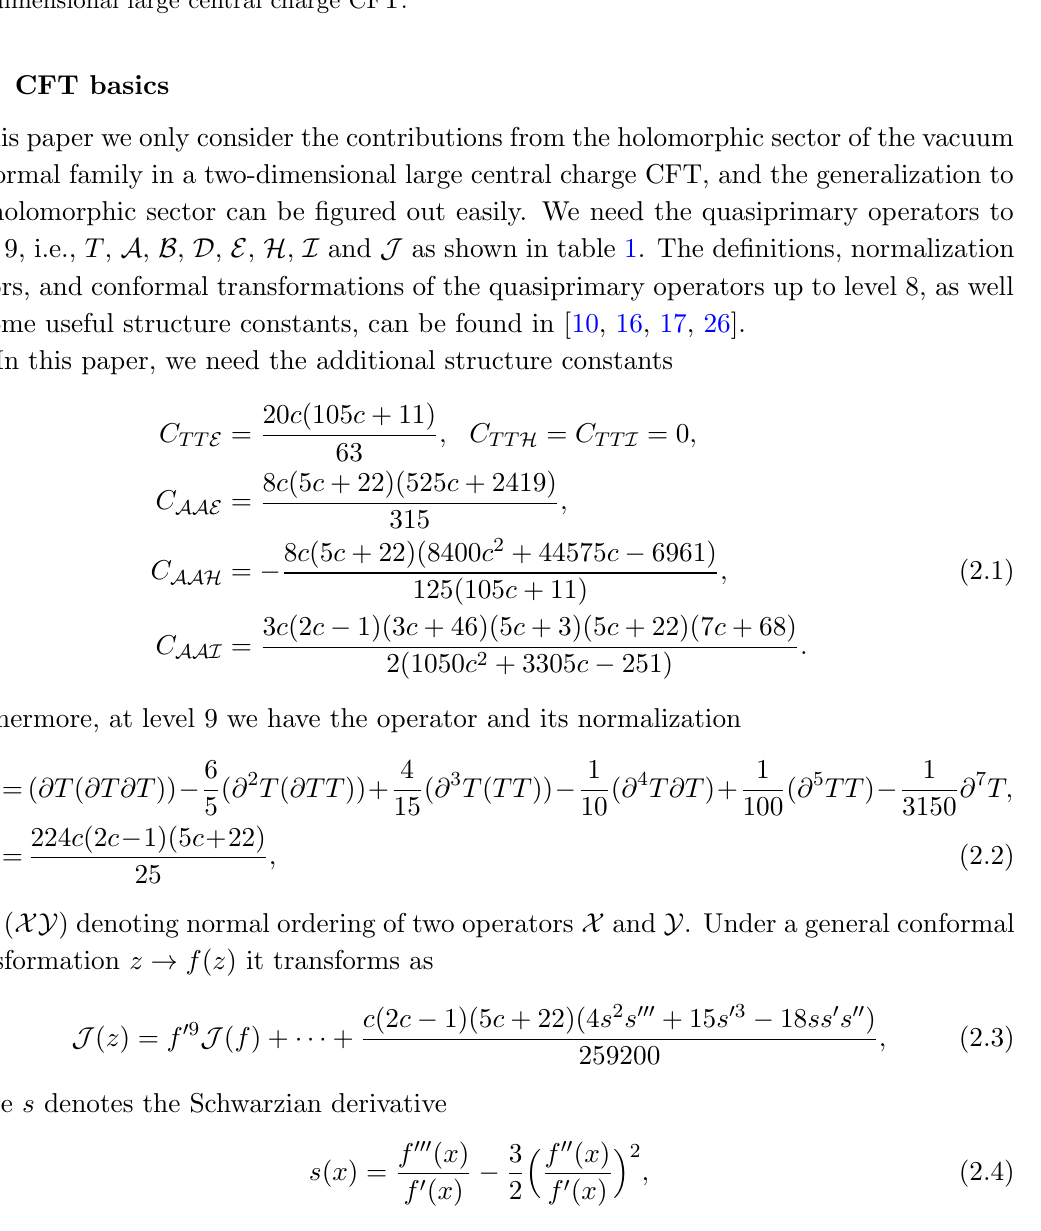
Table 1. The holomorphic quasiprimary operators to level 9 in vacuum conformal family of a two-dimensional large central charge